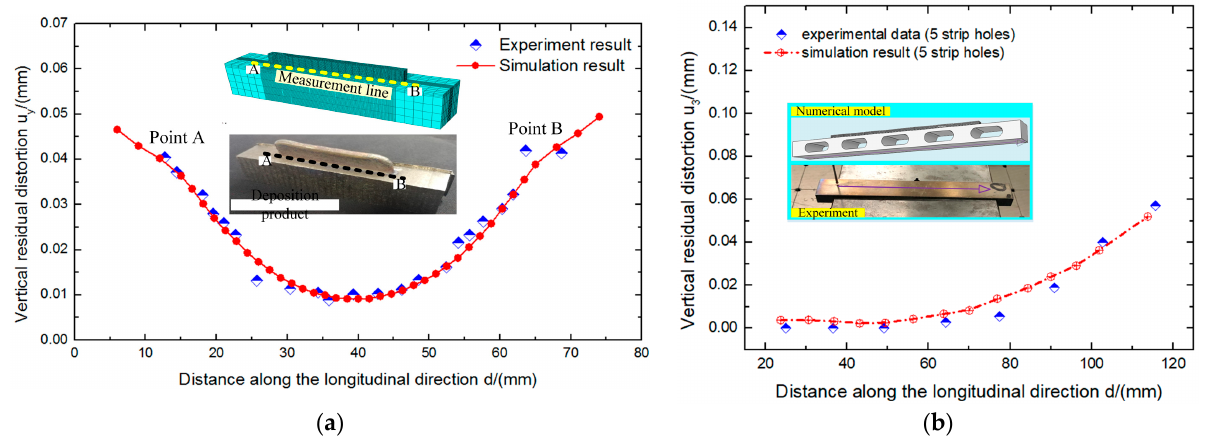
Figure 6. Validation of the residual distortions of the DED AM products: ( a ) product without the substrate design; ( b ) product with the substrate design of the long strip holes.